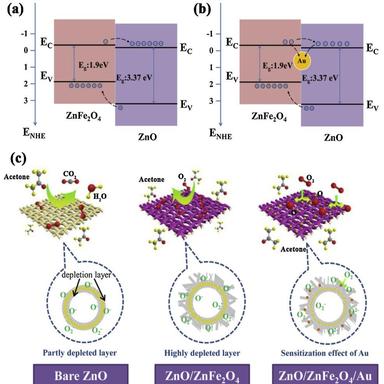
(a and b) Energy level diagram of ZnO/ZnFe2O4 and ZnO/ZnFe2O4/Au heterostructure; (c) schematic illustration of the underlying mechanism for enhanced acetone sensing performance.